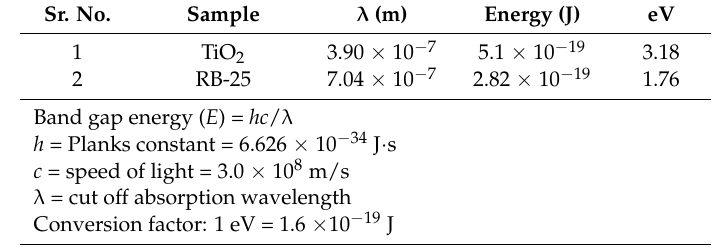
Table 2. Calculations of energy gap.